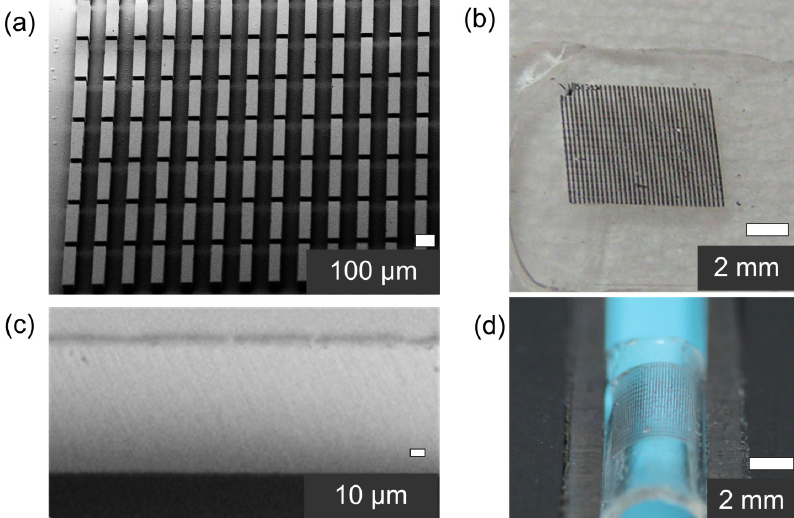
Figure 3. Representative images of the detailed microstructures of a bio-inspired cylindrical lens. SEM images of a portion of a 55-by-50 array of 3-D, high aspect-ratio Si micro-mirrors ( a ) fabricated on the SOI wafer and ( b ) transferred onto a flat PDMS membrane; ( c ) SEM image highlighting the uniformly aluminum-covered, smoothened facets of the micro-mirror where the reflection takes place; ( d ) close-up picture of the micro-mirror array on the PDMS membrane curved into a cylindrical configuration by a lens